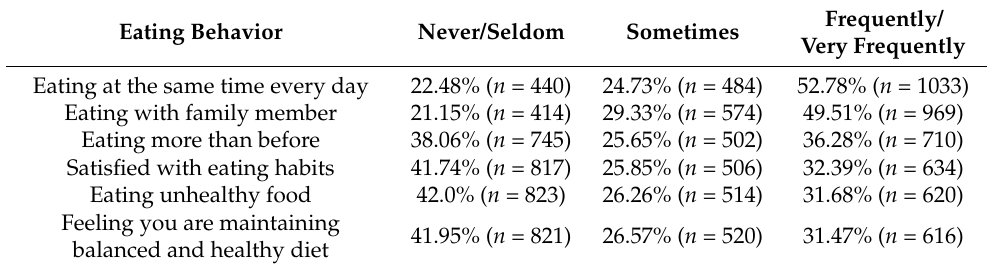
Table 4. Description of the sample’s eating behaviors.